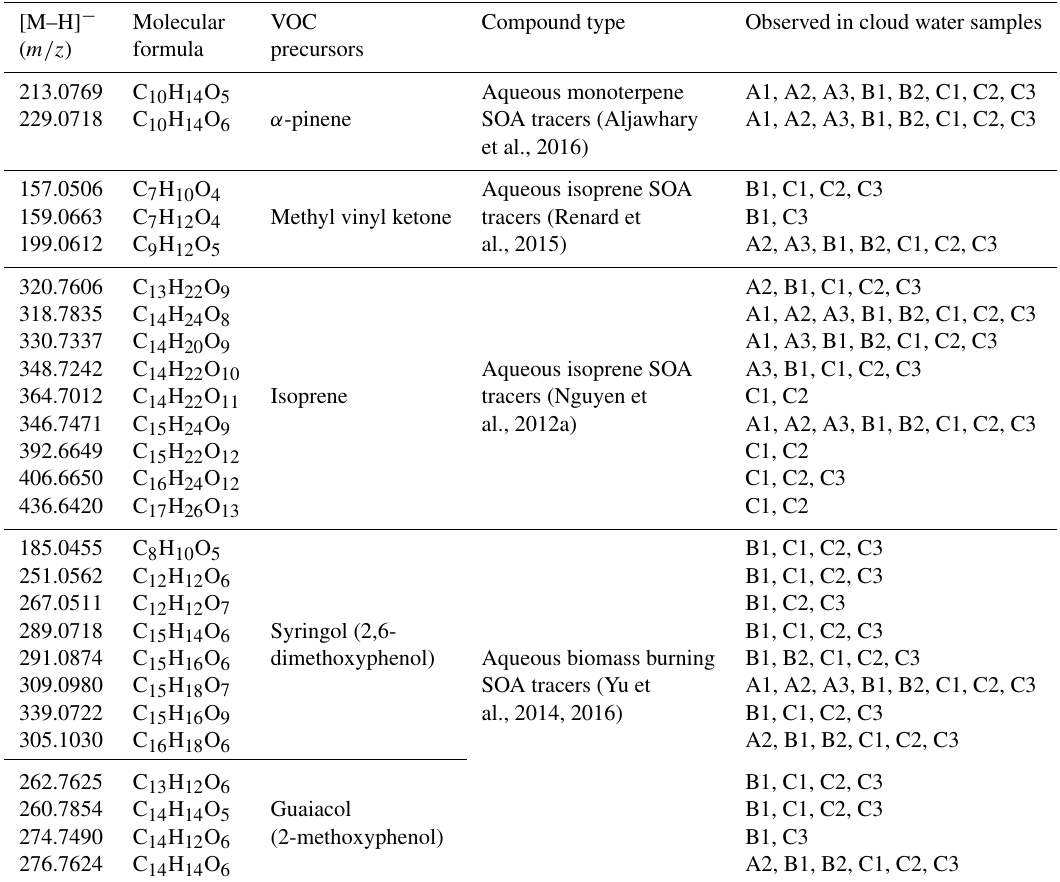
Table 3. Identified aqueous SOA tracers ( m/z , molecular formula, suggested VOC precursor, and compound type, based on bulk aqueous laboratory studies) in each cloud water